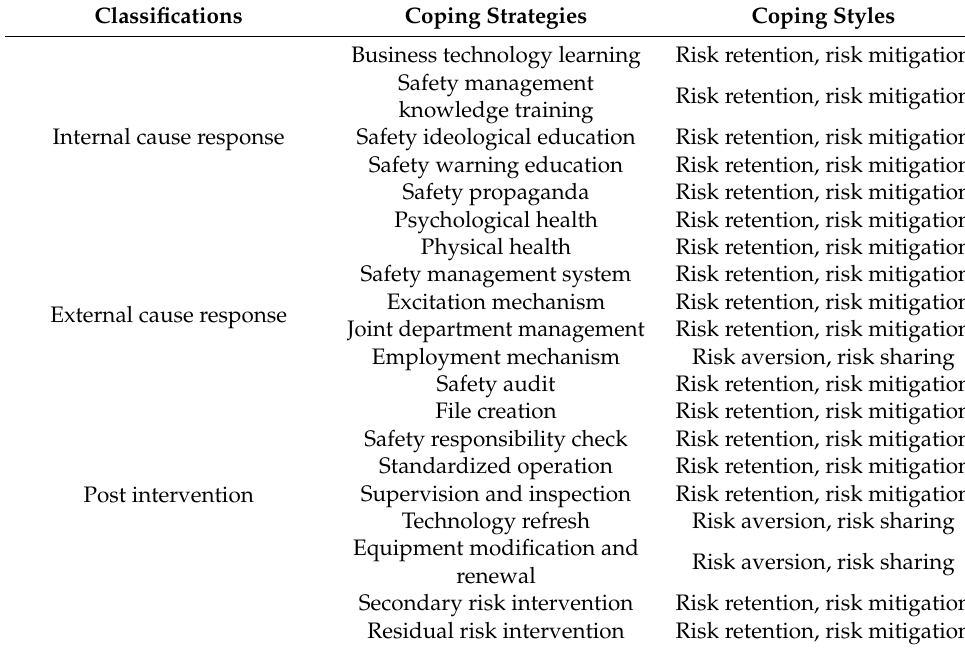
Table 1. Risk response strategy set for grid G H .